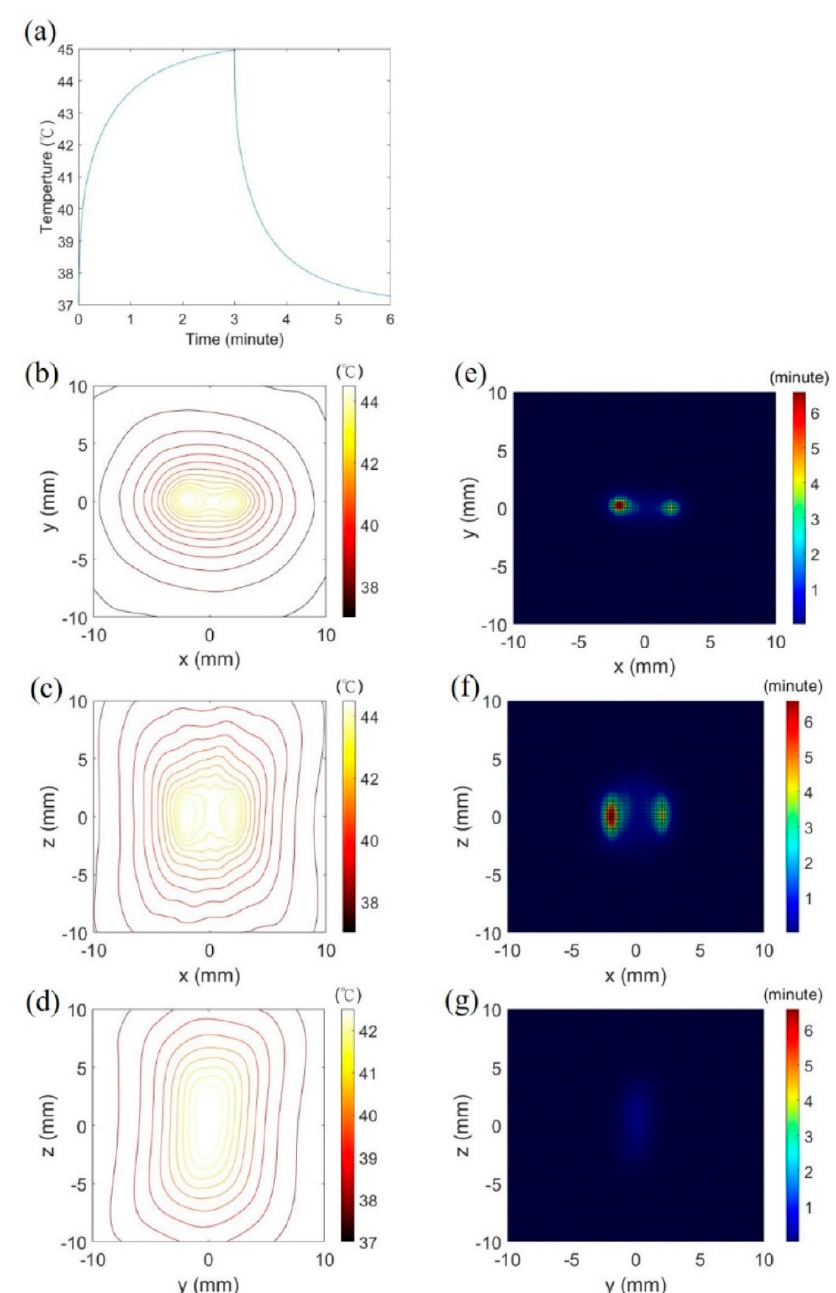
Figure 7. Thermal data of the 114-element transducer with the focusing pattern 1 in the simulation. The peak temperature increased from 37 °C to 41 °C at 11 s and 45 °C at 3 min ( a ). ( b – g ) delineate the spatial distribution of isotherm and thermal dose on three orthogonal plans, respectively.